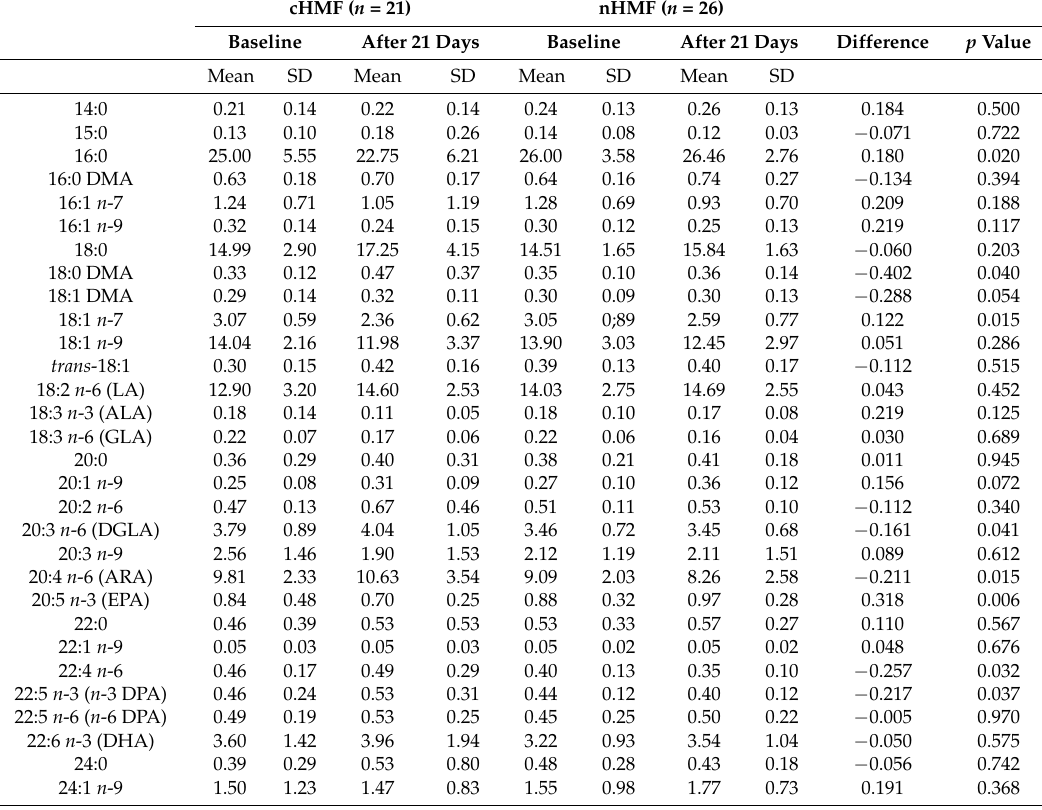
Table 4. (Corrected) Fatty acid profile (g/100 g of fatty acids) of plasma total phospholipids in preterm infants receiving human milk fortified with a control (cHMF) or with a new human milk fortifier (nHMF), before and after 21 days of treatment. Estimations of the treatment effect nHMF/cHMF (difference) and the two-sided p-value are given for each fatty acid analyzed in the different lipid